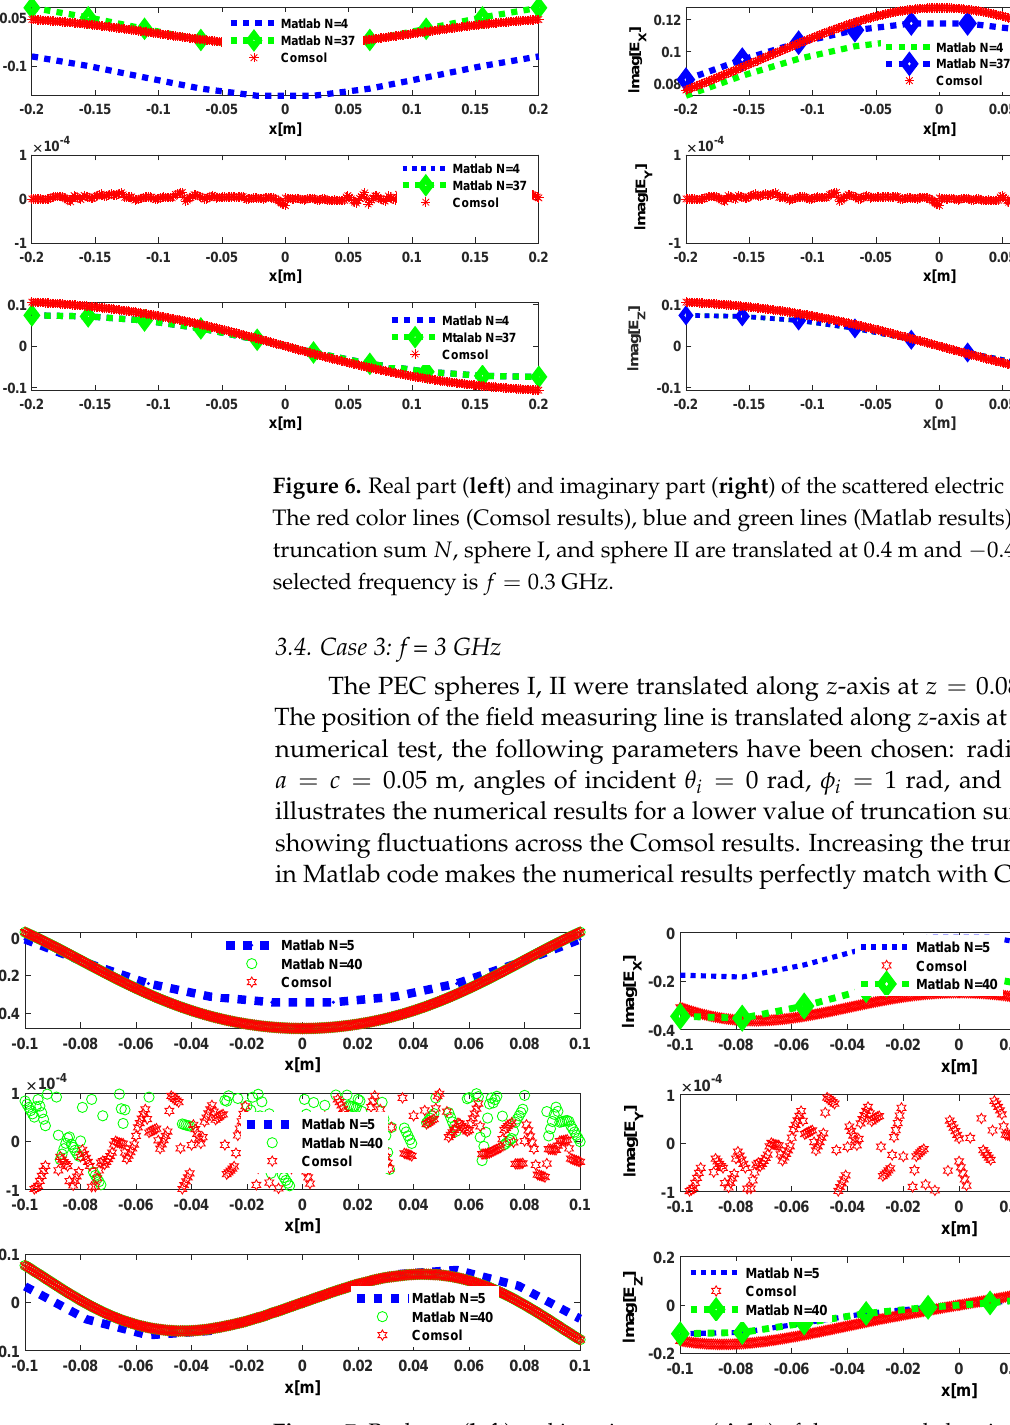
Figure 7. Real part ( left ) and imaginary part ( right ) of the scattered electric field by two PEC spheres. The red color lines (Comsol results), blue and green lines (Matlab results) at different value of the truncation sum N , sphere I and sphere II are translated at 0.08 m and − 0.08 m along z -axis, and the selected frequency is f = 3